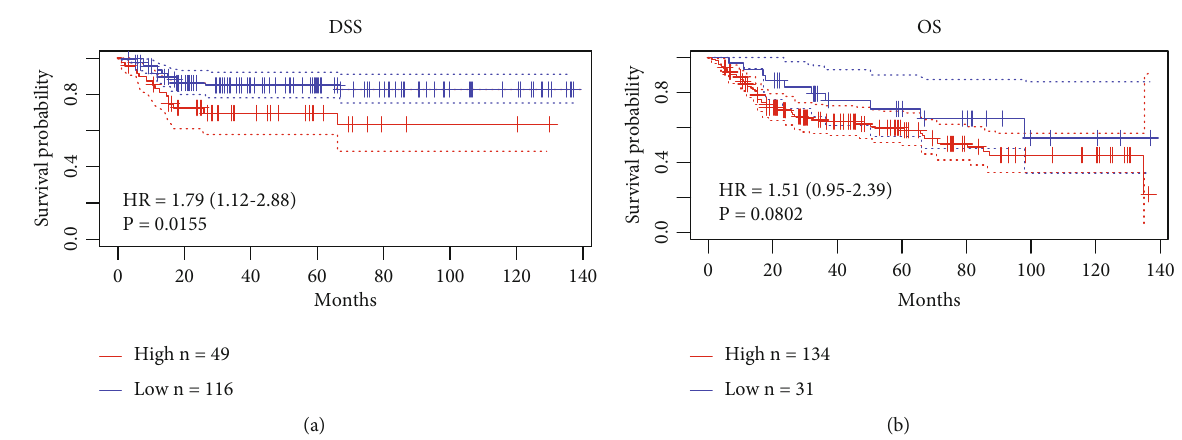
Figure 5: Analysis of Kaplan – Meier survival curves from the PrognoScan database. (a) The disease-speci fi c survival (DSS) curve of TERC (hazard ratio [HR]: 1.79, 95% con fi dence interval [CI]: 1.12 – 2.88, P = 0 : 0155 ). (b) The overall survival (OS) curve of TERC (HR: 1.51, 95% CI: 0.95 – 2.39, P = 0 : 0802 ). HR > 1 indicates a risk factor associated with poor patient